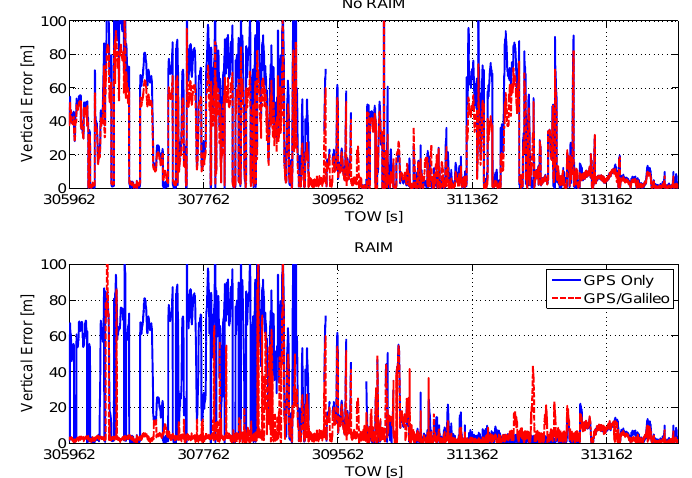
Figure 11. Vertical position error as a function of time. Upper box: vertical errors of the configuration without RAIM application; lower box: vertical errors of the configurations with RAIM.